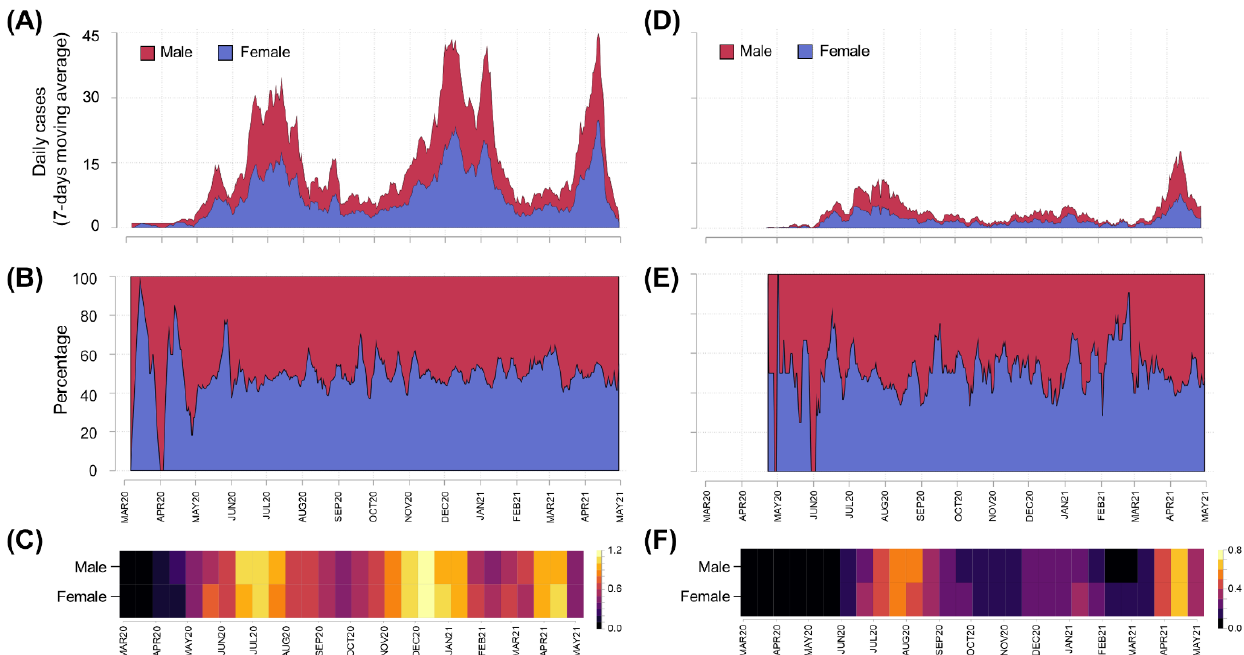
Figure 3. Age-stratified epidemic curves for Bolívar and Cartagena, as of 31 April 2021. Daily con- firmed new cases were presented using epidemic curves (panels ( A , D )) and stacked area plots (pan- els ( B , E )) on linear scales, while cases per 100,000 population were presented using heat maps (pan- els ( C , F )) with log (x + 1) scales to improve readability. Data for Cartagena (panels ( A – C )) and other municipalities of Bolívar (panels ( D – F )) were presented using symptom onset dates and 7-day mov- ing averages.